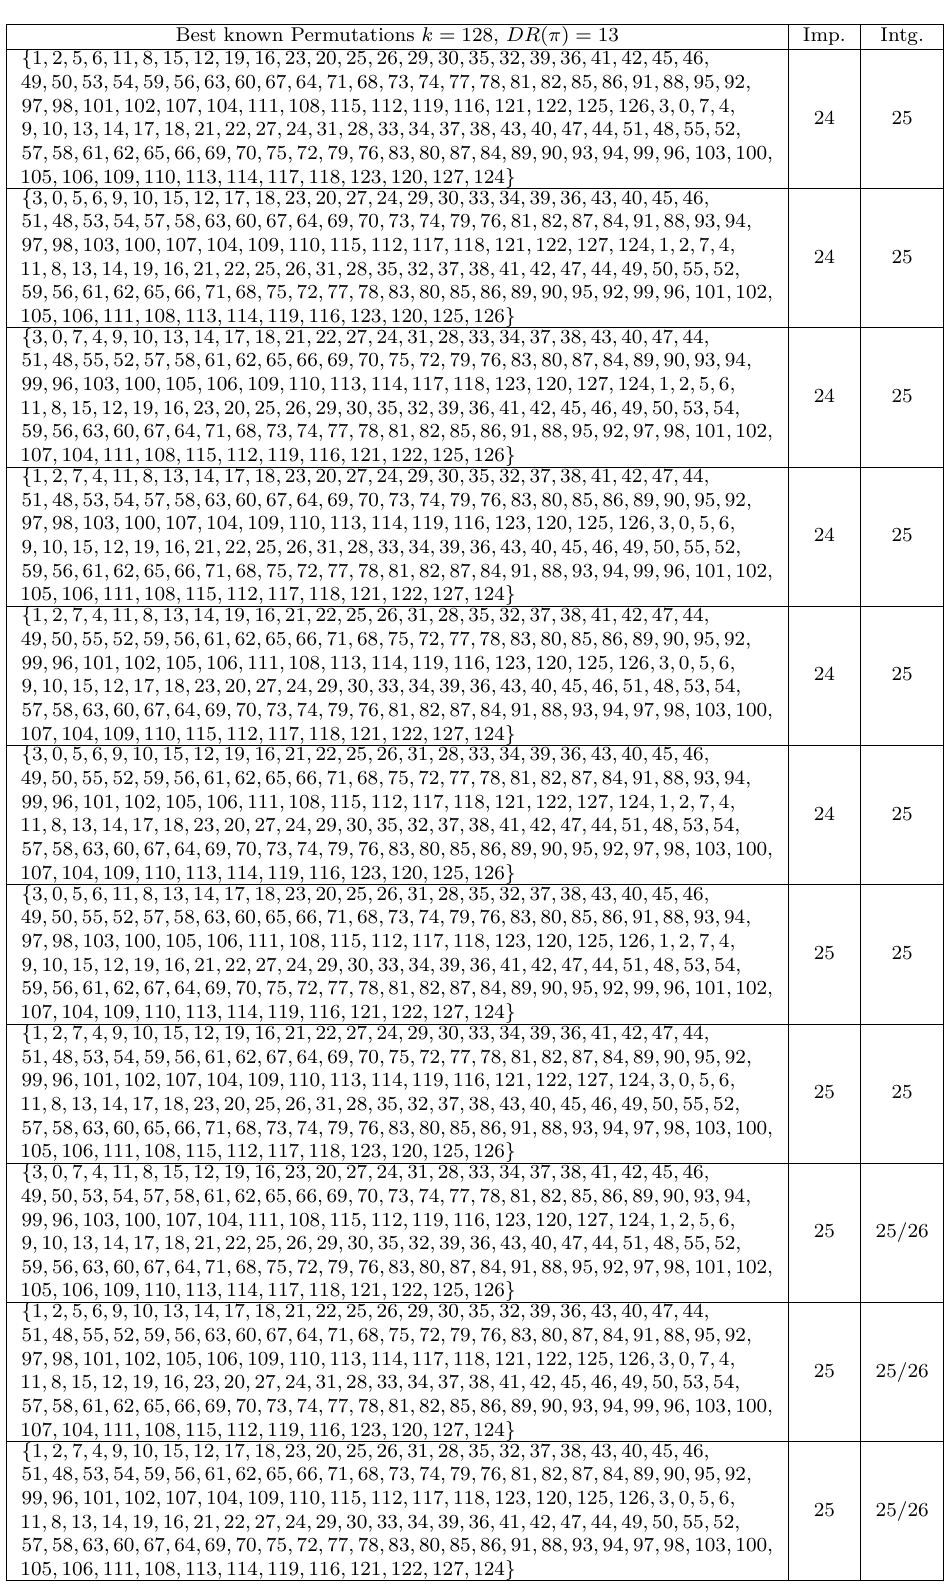
Table 24: Best known permutations k = 128 Best known Permutations k = 128, DR ( π ) = 13